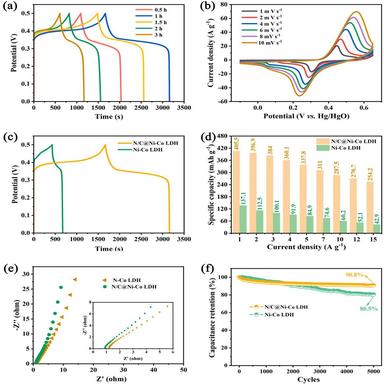
(a) The comparison of N/C@Ni-Co LDH electrodes with different hydrothermal times at 1 A g−1. (b) CV curves of N/C@Ni-Co LDH electrode (2 h). (c-f) comparisons between Ni-Co LDH and N/C@Ni-Co LDH in terms of (c) GCD, (d) specific capacity, (e) EIS and (f) cycling stability.